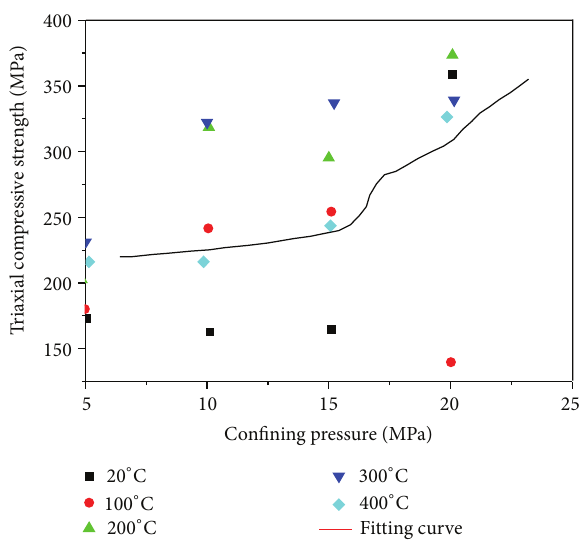
Figure 9: Triaxial compressive strength curve with confining pressure and temperature.